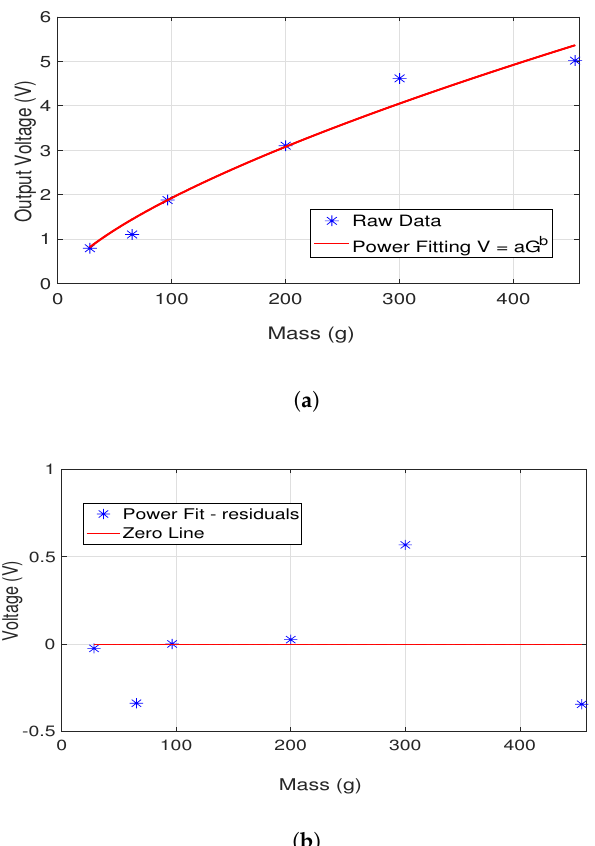
Figure 8. Calibration measurements: ( a ) the power fitting to the calibration values; ( b ) residuals of the power